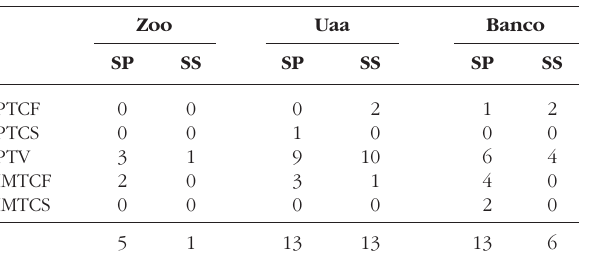
Un total de 32,7 % d’infections vues au microscope n’ont pu être